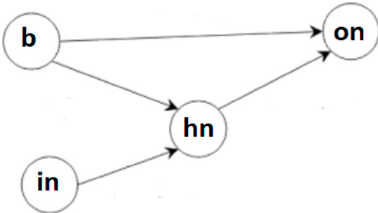
Figure 2. An ANN scheme with an input node (in), a bias node (b), a hidden node (hn), and an output node (on).